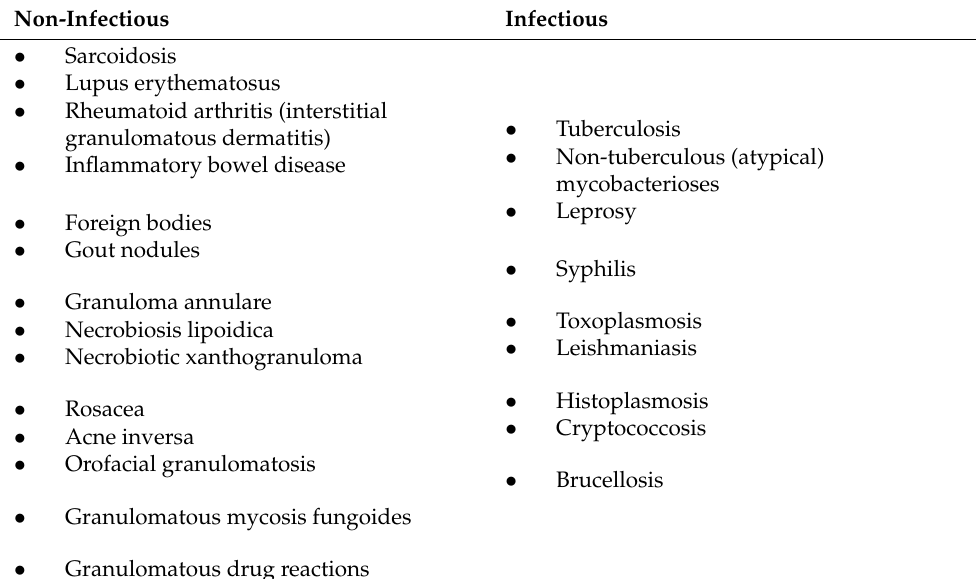
Table 1. Examples of granulomatous skin diseases. Adapted from